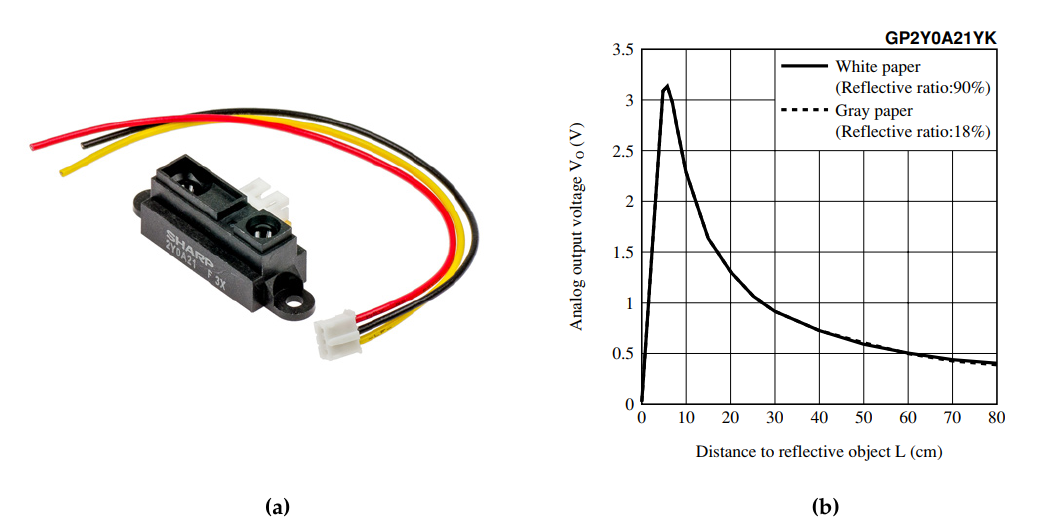
Figure 1. ( a ) Sharp GPY2Y0A21YK infrared distance sensor and ( b ) voltage vs. distance